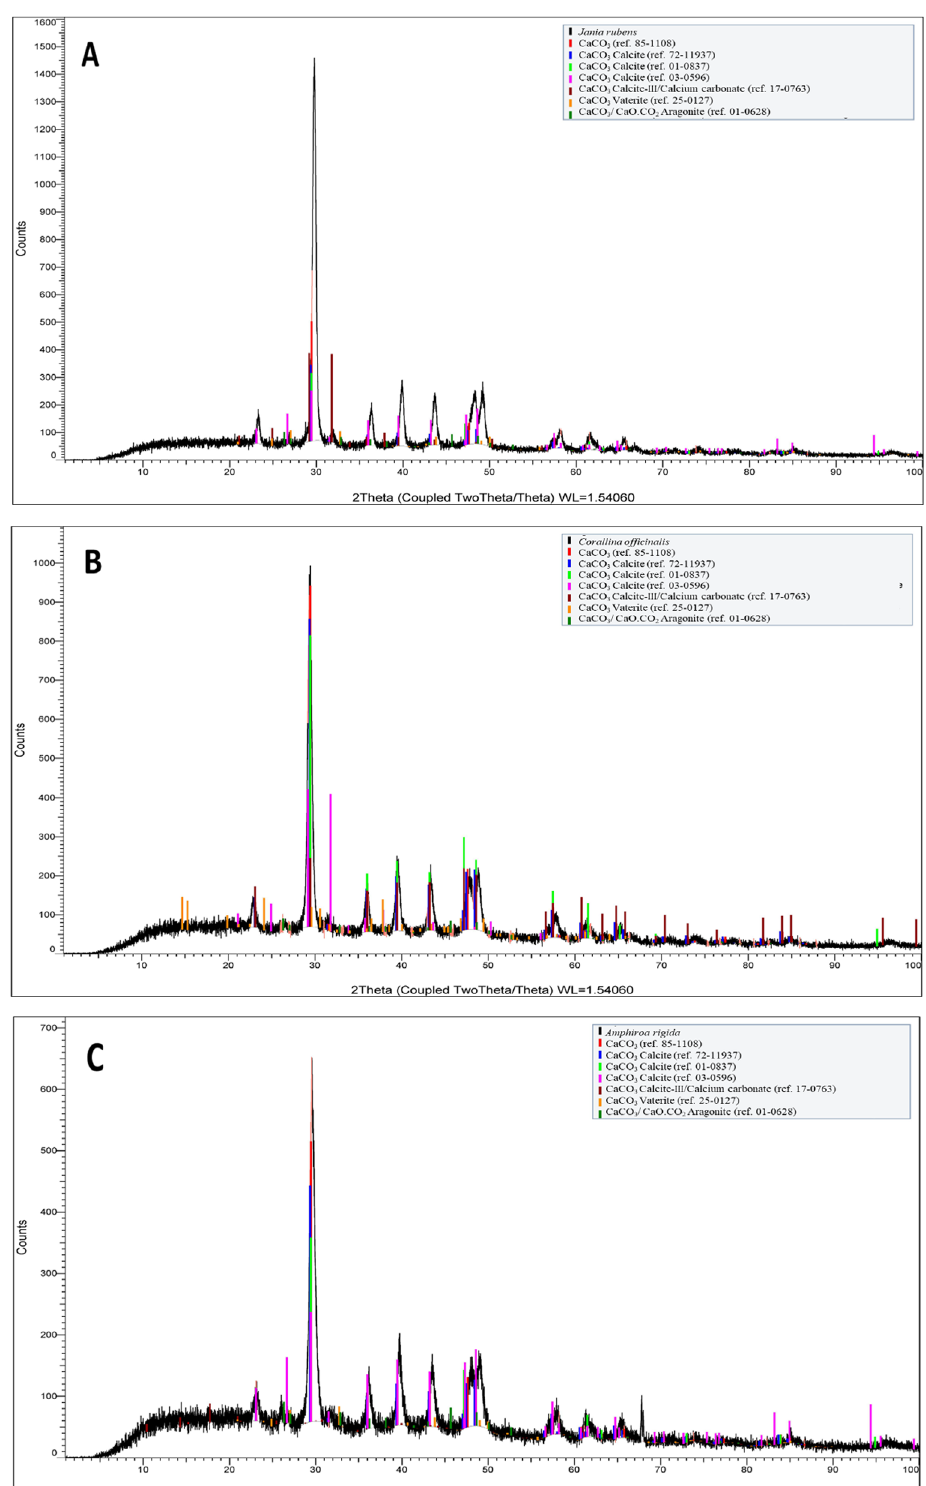
Fig. 12 X-ray diffraction patterns of the selected seaweed: A Jania rubens and B Corallina officinalis ; C Amphiroa